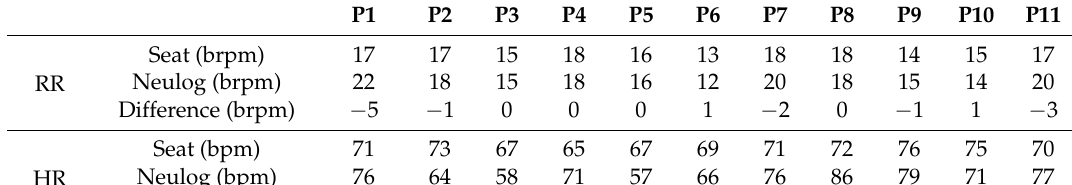
Table 2. Resting RR and HR Derived from Seat and Neulog Sensors for Eleven Participants